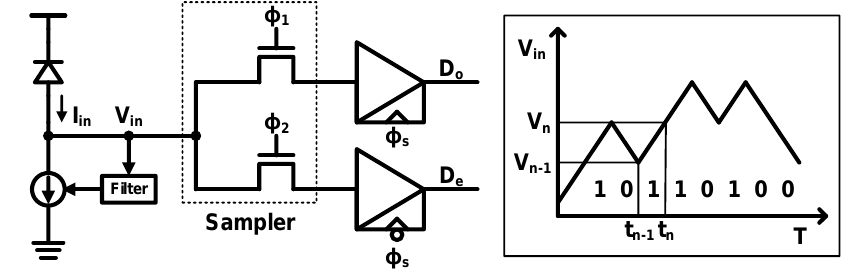
Figure 28. Integrating receiver based on double sampling.